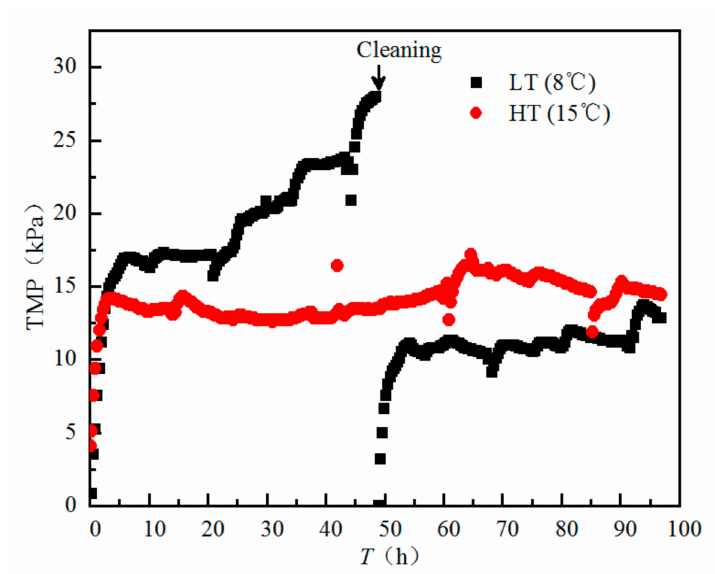
Figure 6. Development of the trans-membrane pressure (TMP) of high loaded bioflocculation membrane reactors (HLB-MRs) at di ff erent